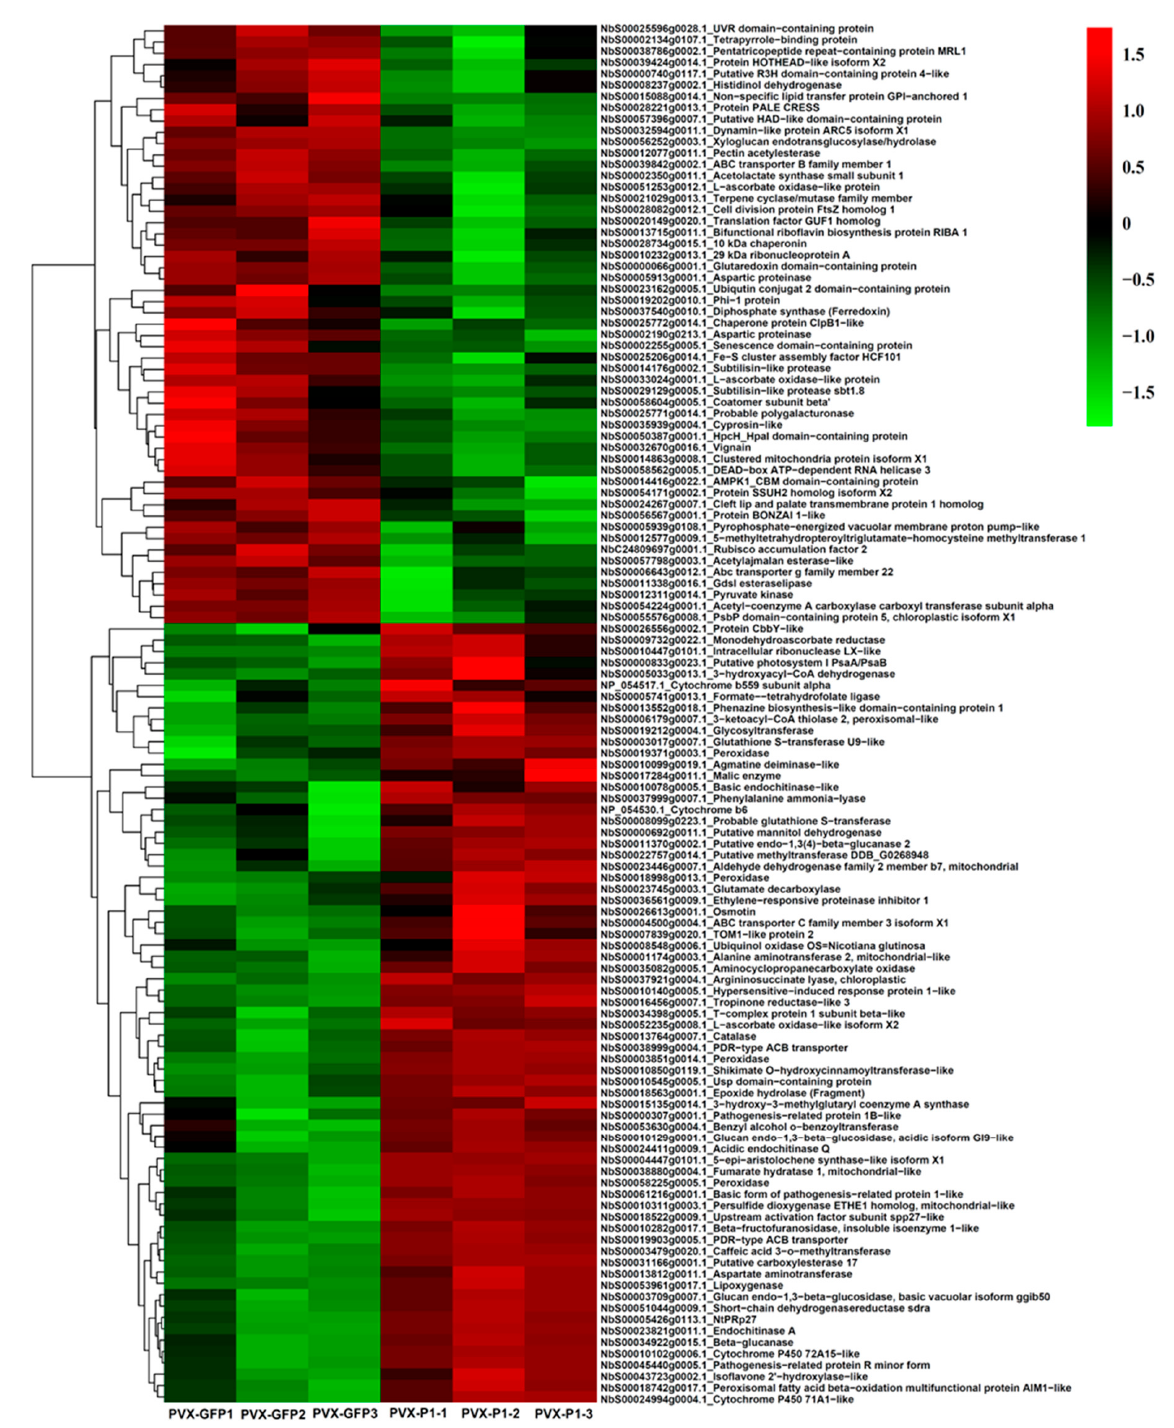
Figure 2. Heat map of the differentially accumulated proteins (DAPs) under heterogeneous expres- sion of P1 SCSMV in Nicotiana benthamiana